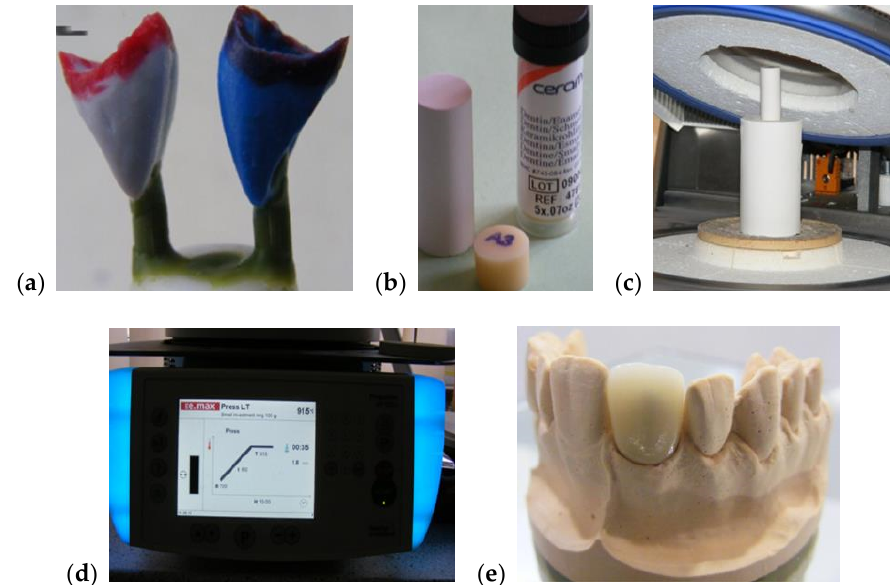
Figure 1. Aspects from the samples preparation: ( a ) making of the wax ups; ( b ) pressed ingots used in the study; ( c ) positioning of dental material in the oven in order to press the ceramic ingot; ( d ) ceramic pressing procedure; ( e ) example of a final dental ceramic crown.